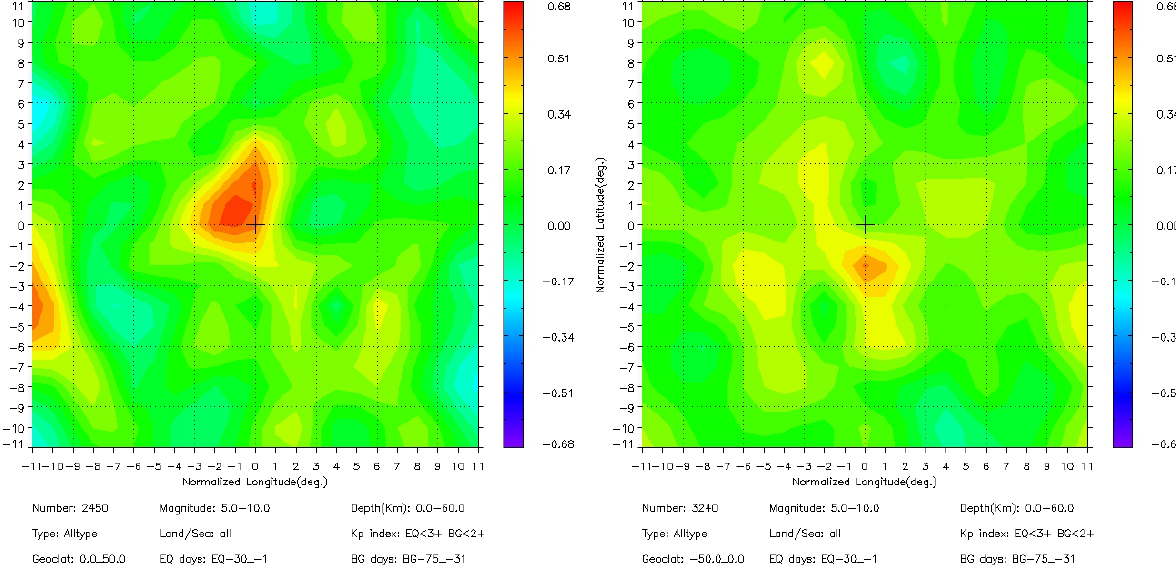
Fig. 3. The plots are similar to the right panel of Fig. 2, but it concerns statistical results with seismic events occurring in the Northern Hemisphere (left panel) and in the Southern Hemisphere (right